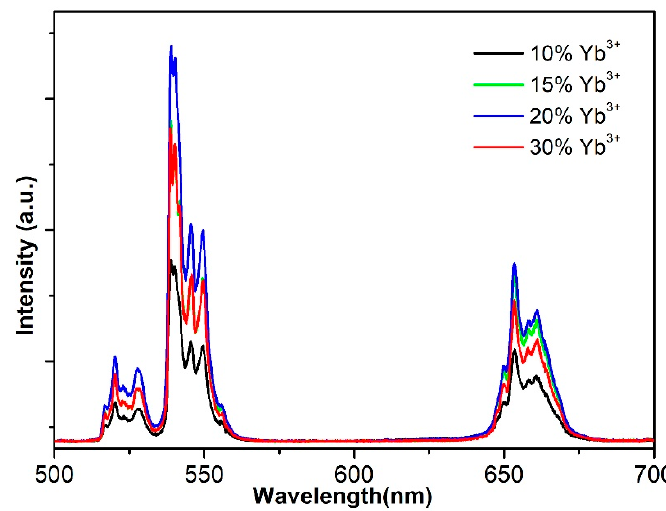
Figure 3. The UC emission spectrum of NaYF 4 :x%Yb 3+ ,2%Er 3+ .